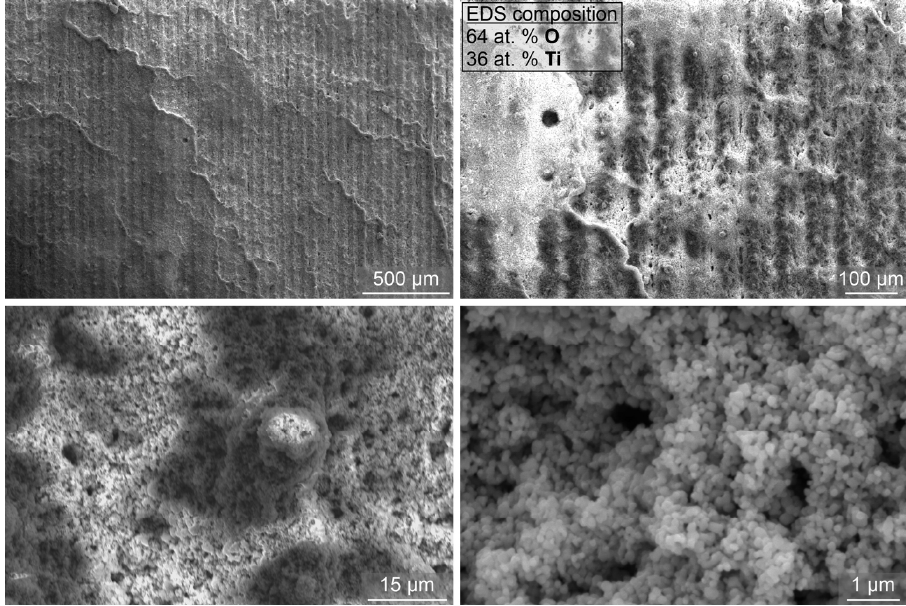
Figure 8. SEM images of the laser-textured sample LT after exposure to boiling 0.1 wt.% nanofluid with large nanoparticles (i.e., L-0.1).